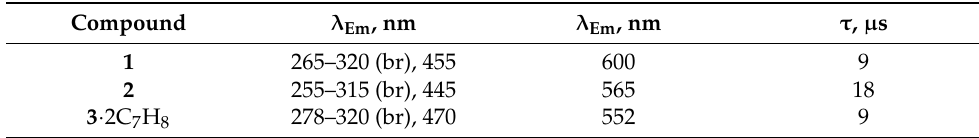
Table 2. Photophysical properties of compounds 1 [19], 2 and 3 · 2C 7 H